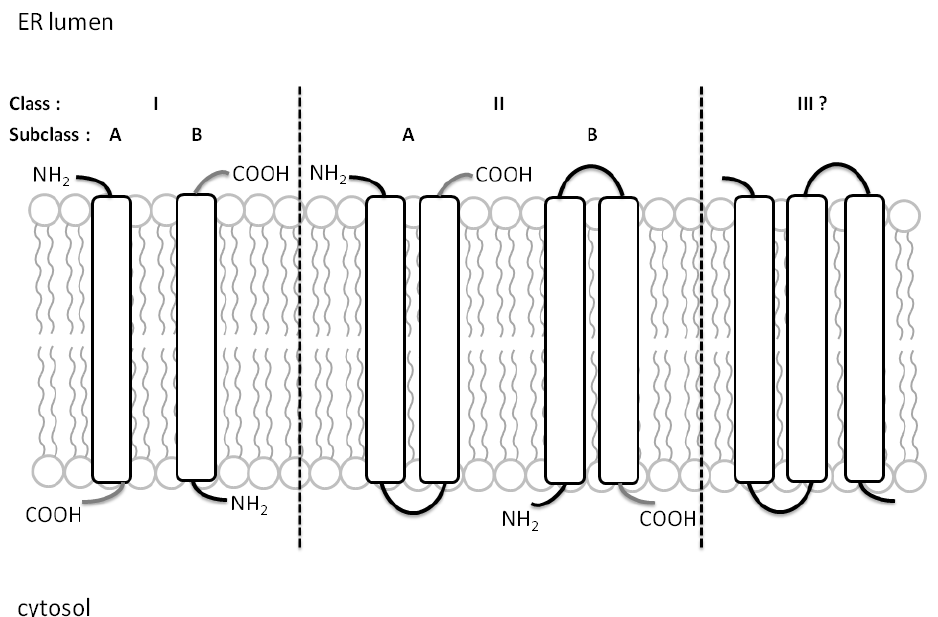
Figure 1. Classification of viroporins based on their membrane topology. Class I and Class II viroporins have one and two TMD, respectively. Class IA viroporins have their N-termini facing the ER lumen while Class IB have their C-termini in the cytosolic side. Class IIA viroporins have both the N- and C-termini in the lumenal side while Class IIB have them facing the cytosol. A putative Class III viroporin with three TMDs is depicted in this figure, following the proposal of viroporins with three TMDs. Figure adapted from [2].